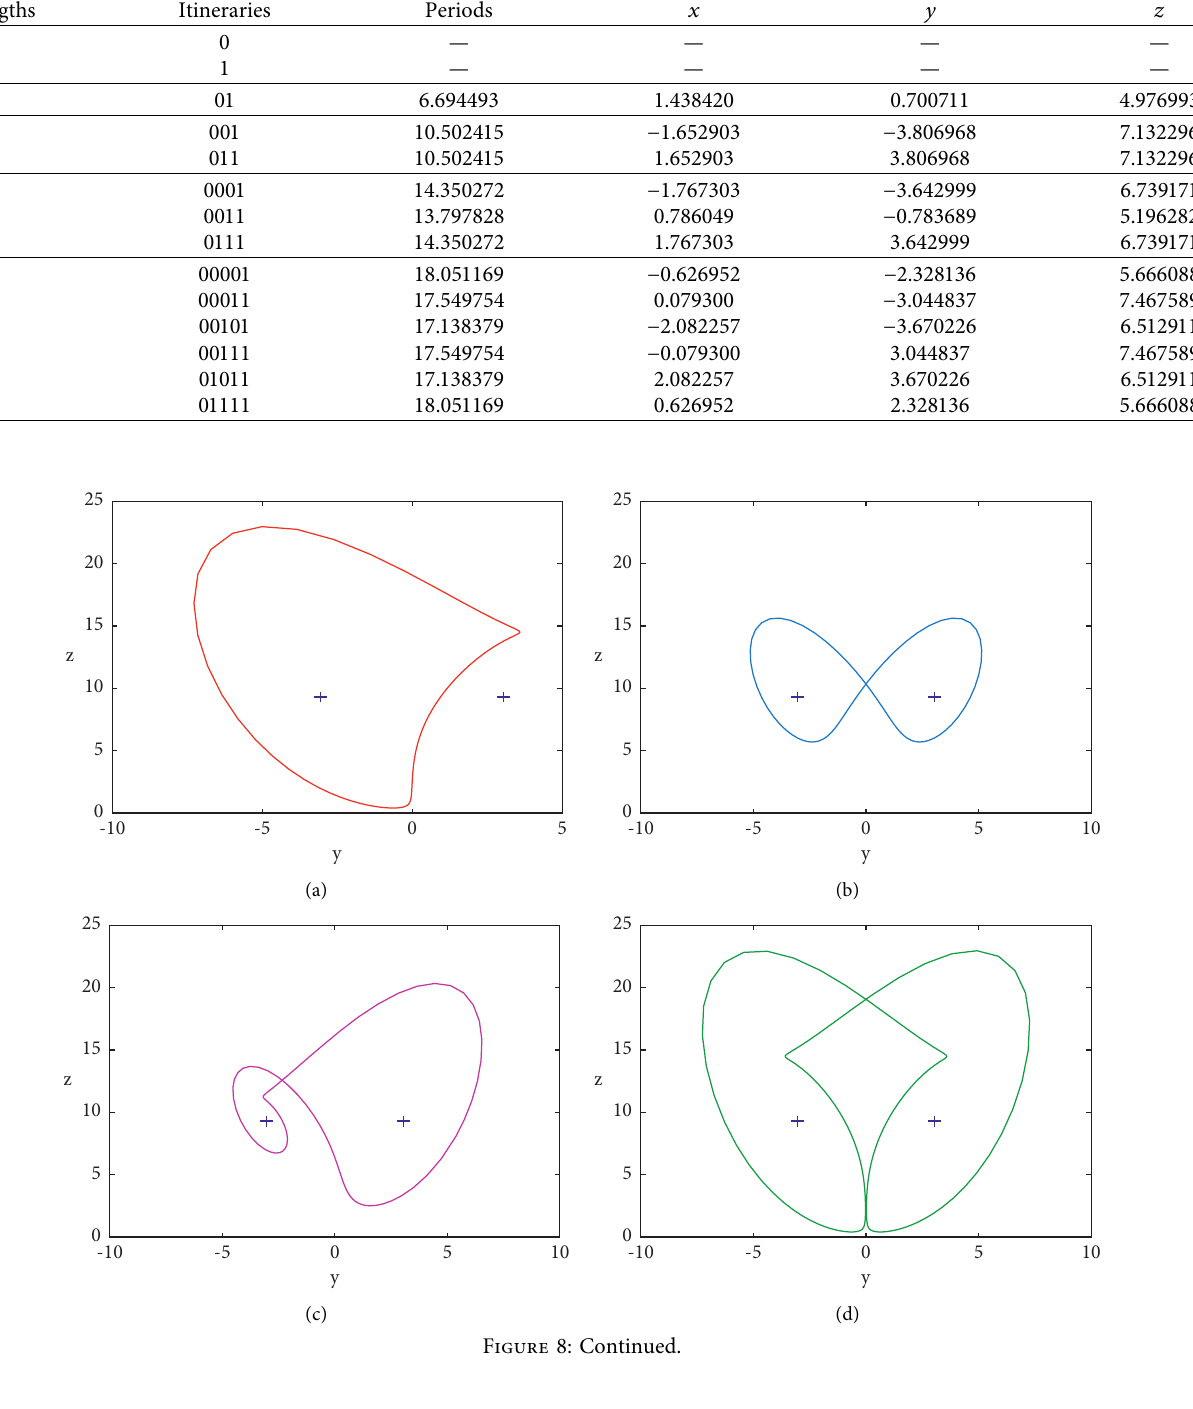
Table 1: Twelve unstable cycles in the Rucklidge system for ( a,b ) � ( 2 , 6 . 7 ) . The topological lengths, itineraries, periods, and coordinates of a point on the cycle are